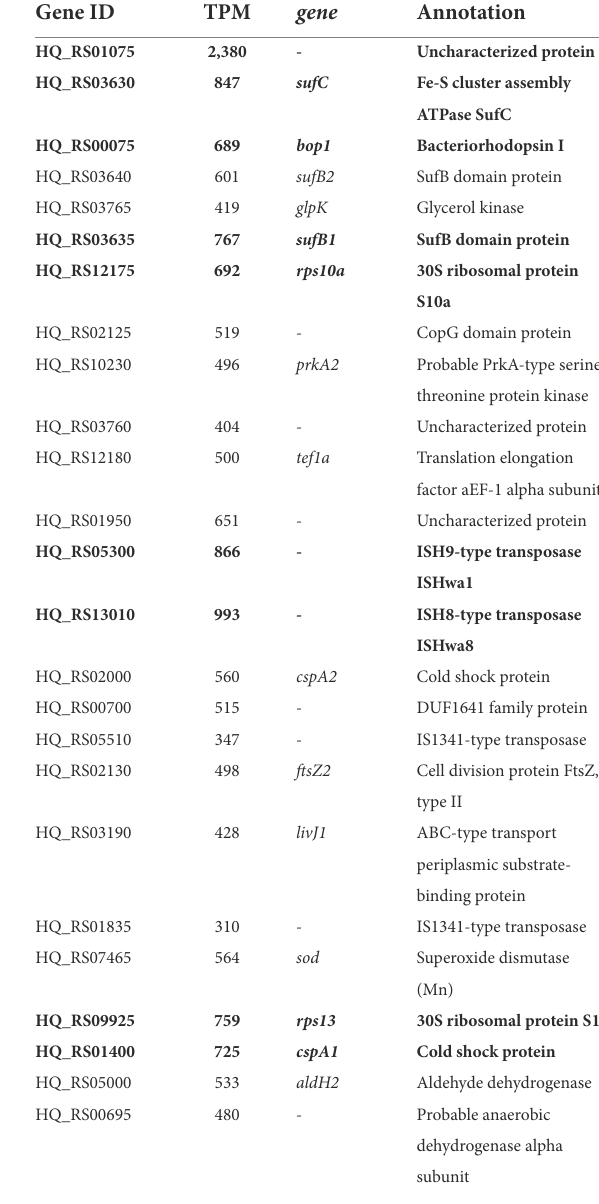
Genes in bold indicated genes that are highly expresses in both summer and